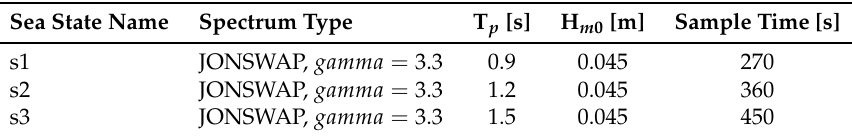
Table 2. Sea state characteristics, water depth 0.60